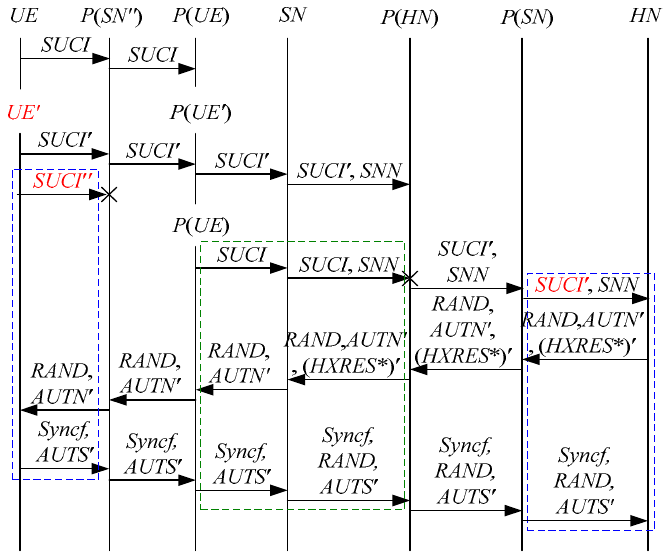
Figure 18. The seventeenth attack scenario of the 5G AKA protocol.